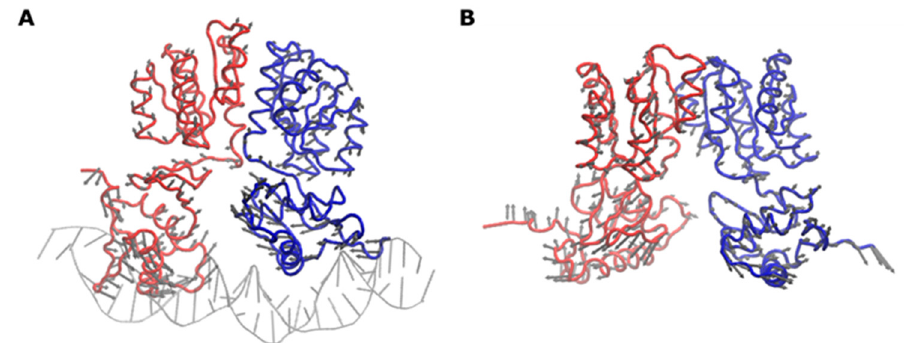
Figure 5. Vector field representation of the PC1 obtained from Normal model analysis of DNA-bound complex ( A ) and unbound HP1043. ( B ). Chain A is represented in red, chain B in blue and DNA is in light gray. Gray arrows show the motion quantity and direction.